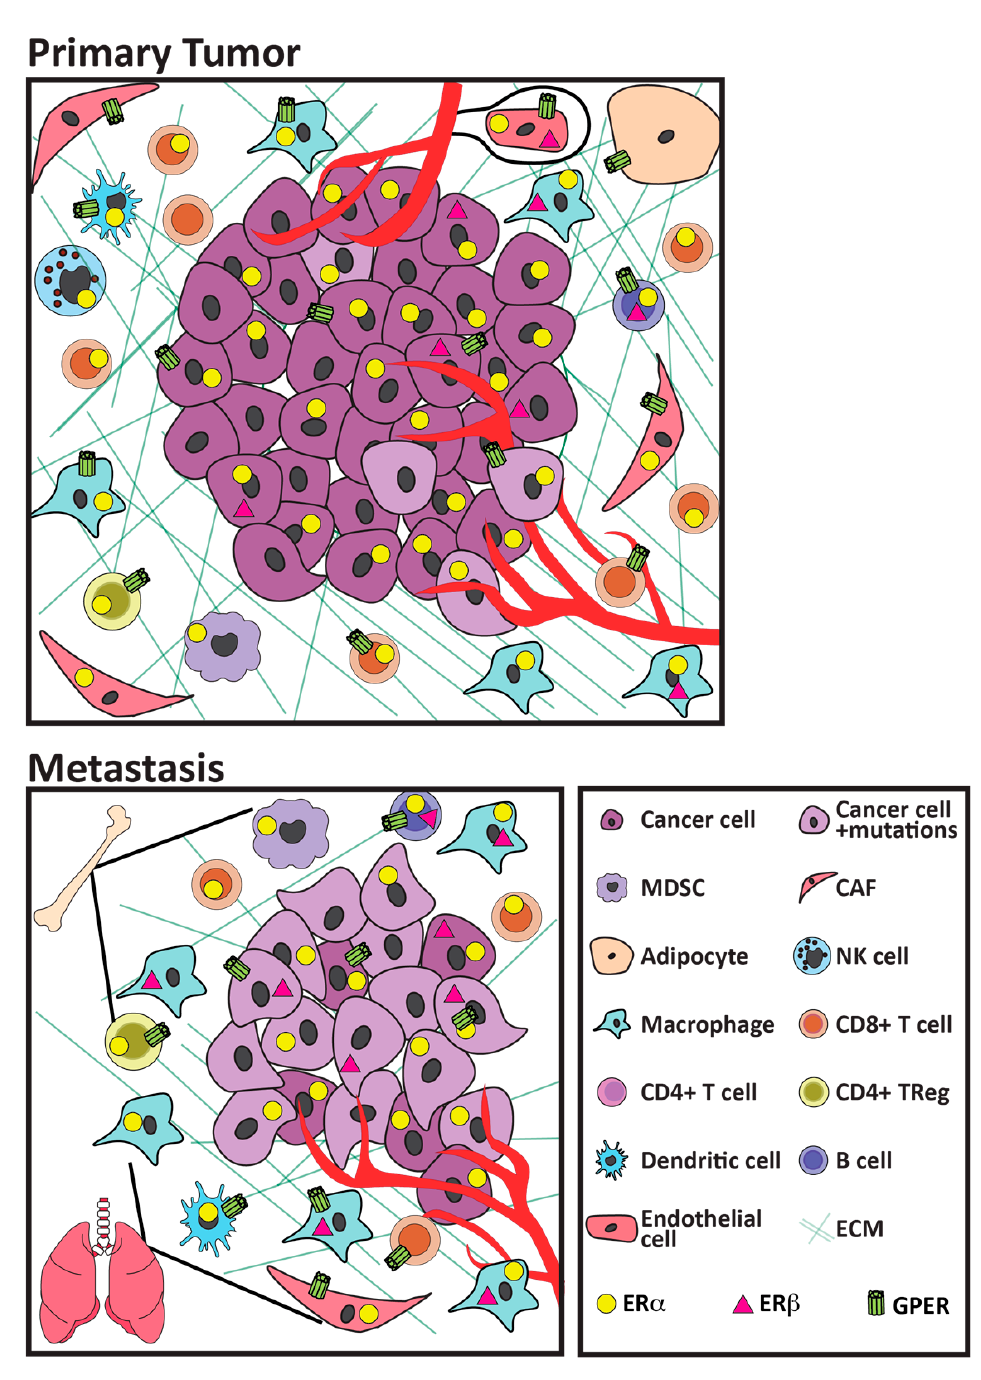
Figure 1. Schematic distribution of estrogen receptors in the microenvironments of primary and metastatic ER+ cancers. Multiple immune cells and other stromal cells in addition to the cancer cells themselves can express multiple distinct estrogen receptors, with different responses to anti-estrogen therapies (see Sections 2–4). Top, microenvironment of primary ER+ cancer, enriched in macrophage populations. Bottom, metastatic ER+ lesion, which is enriched in tumor cells selected/evolved for the site, with larger macrophage and reduced CD8+ cell subpopulations. (Data compiled from [24,39–43]). Note that these cell populations exhibit a spectrum of functional states which are likely to display changing levels of receptor expression. Cell responses would be determined by estrogenic ligand, relative numbers of receptors, cell-specific co-activators, and environmental